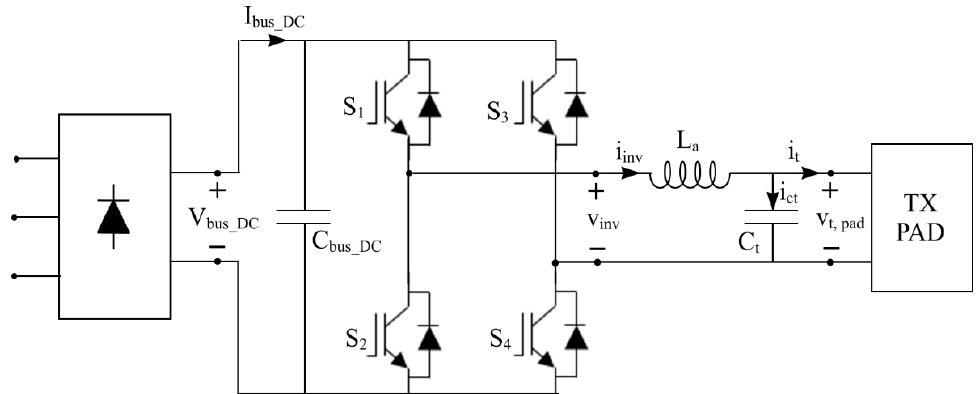
Figure 11. Electrical scheme of the transmitting section. The inverter is a “classical” H bridge, three levels, while the rectified is three-phases bridge one.